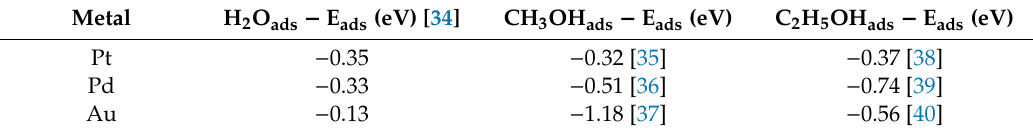
Table 2. Adsorption energies (Eads) for H 2 O, methanol, and ethanol on several metal